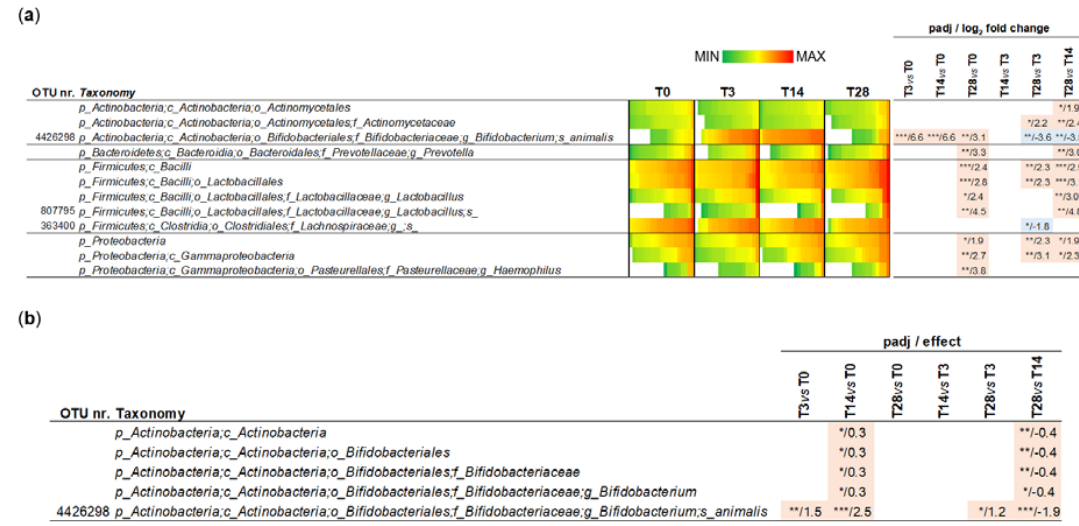
Figure 3. Significantly different operational taxonomic units (OTUs) determined with DESeq2 ( a ) and ALDEx2 ( b ) normalization. Asterisks refer to FDR-adjusted p values (padj) from Welch’s Test (*** p < 0.001; ** p < 0.01; * p < 0.05). O TU 4426298 ( B . anim alis susp. lactis )